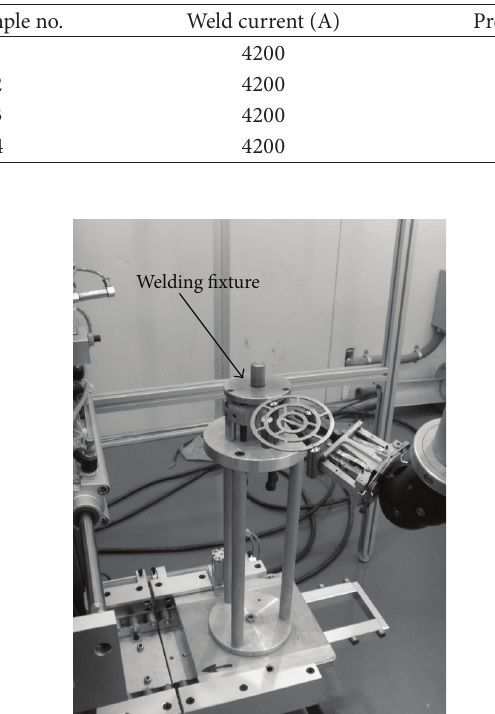
Table 1: Resistance welding conditions of the weld performance test.